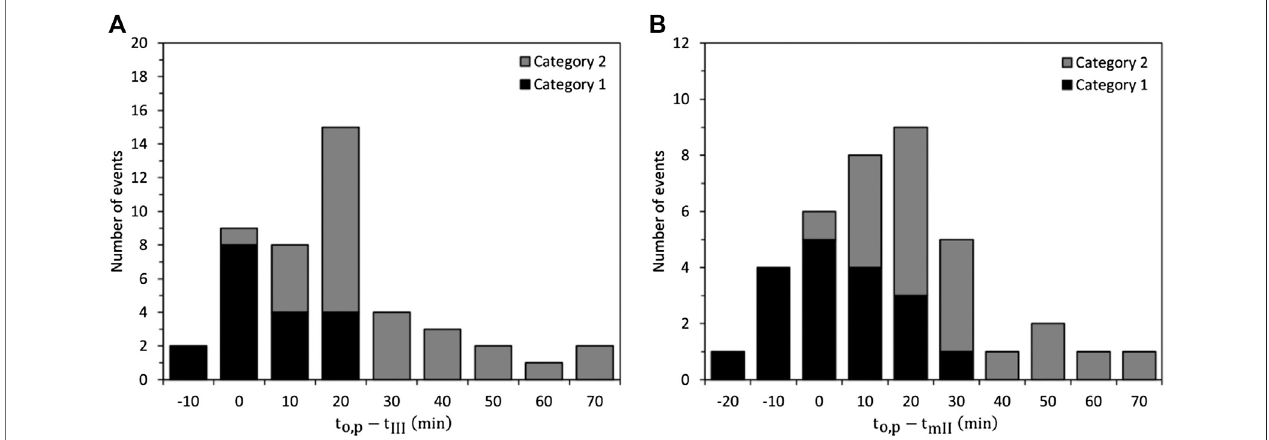
FIGURE 1 | Comparisons of the release time delays of the fi rst solar energetic particles detected by SoHO/ERNE and the start of radio bursts of type III (left) and metre-wavetypeII (right) .TheSEPreleasestartsduringametre-wavetypeIIburstineventsofcategory1,andduringorafterthestartofaDHtypeIIburstincategory2. From Ameri et al.